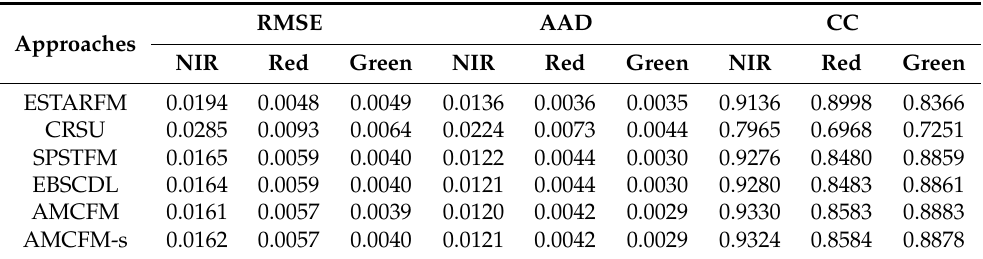
Table 5. Band quality metrics in image